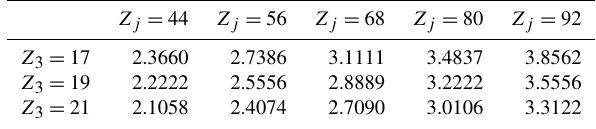
Table 1. Relationship connecting tooth numbers of cylindrical, face gears and transmission ratios of planetary